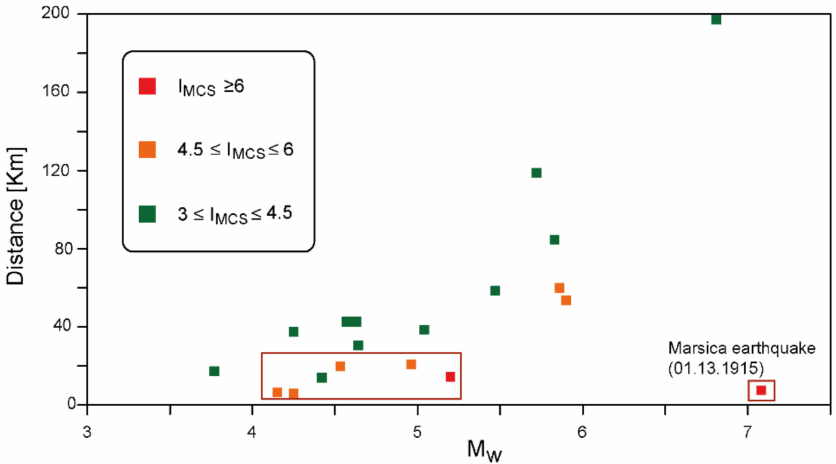
Figure 16. Mw-Distance pairs for events responsible of different macroseismic intensities, I MCS , at the Lucus Angitiae site: red squares refer to I MCS ≥ 6, orange squares refer to 4.5 ≤ I MCS < 6, while green squares to 3 ≤ I MCS <